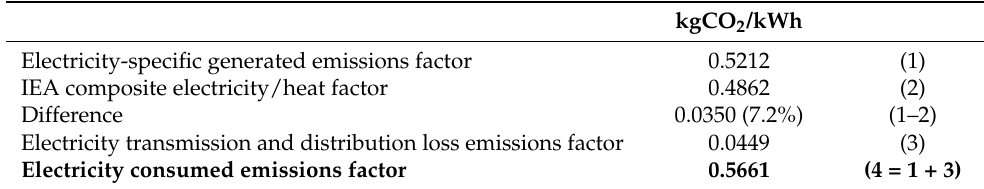
Table 4. Electricity-specific emissions factors.